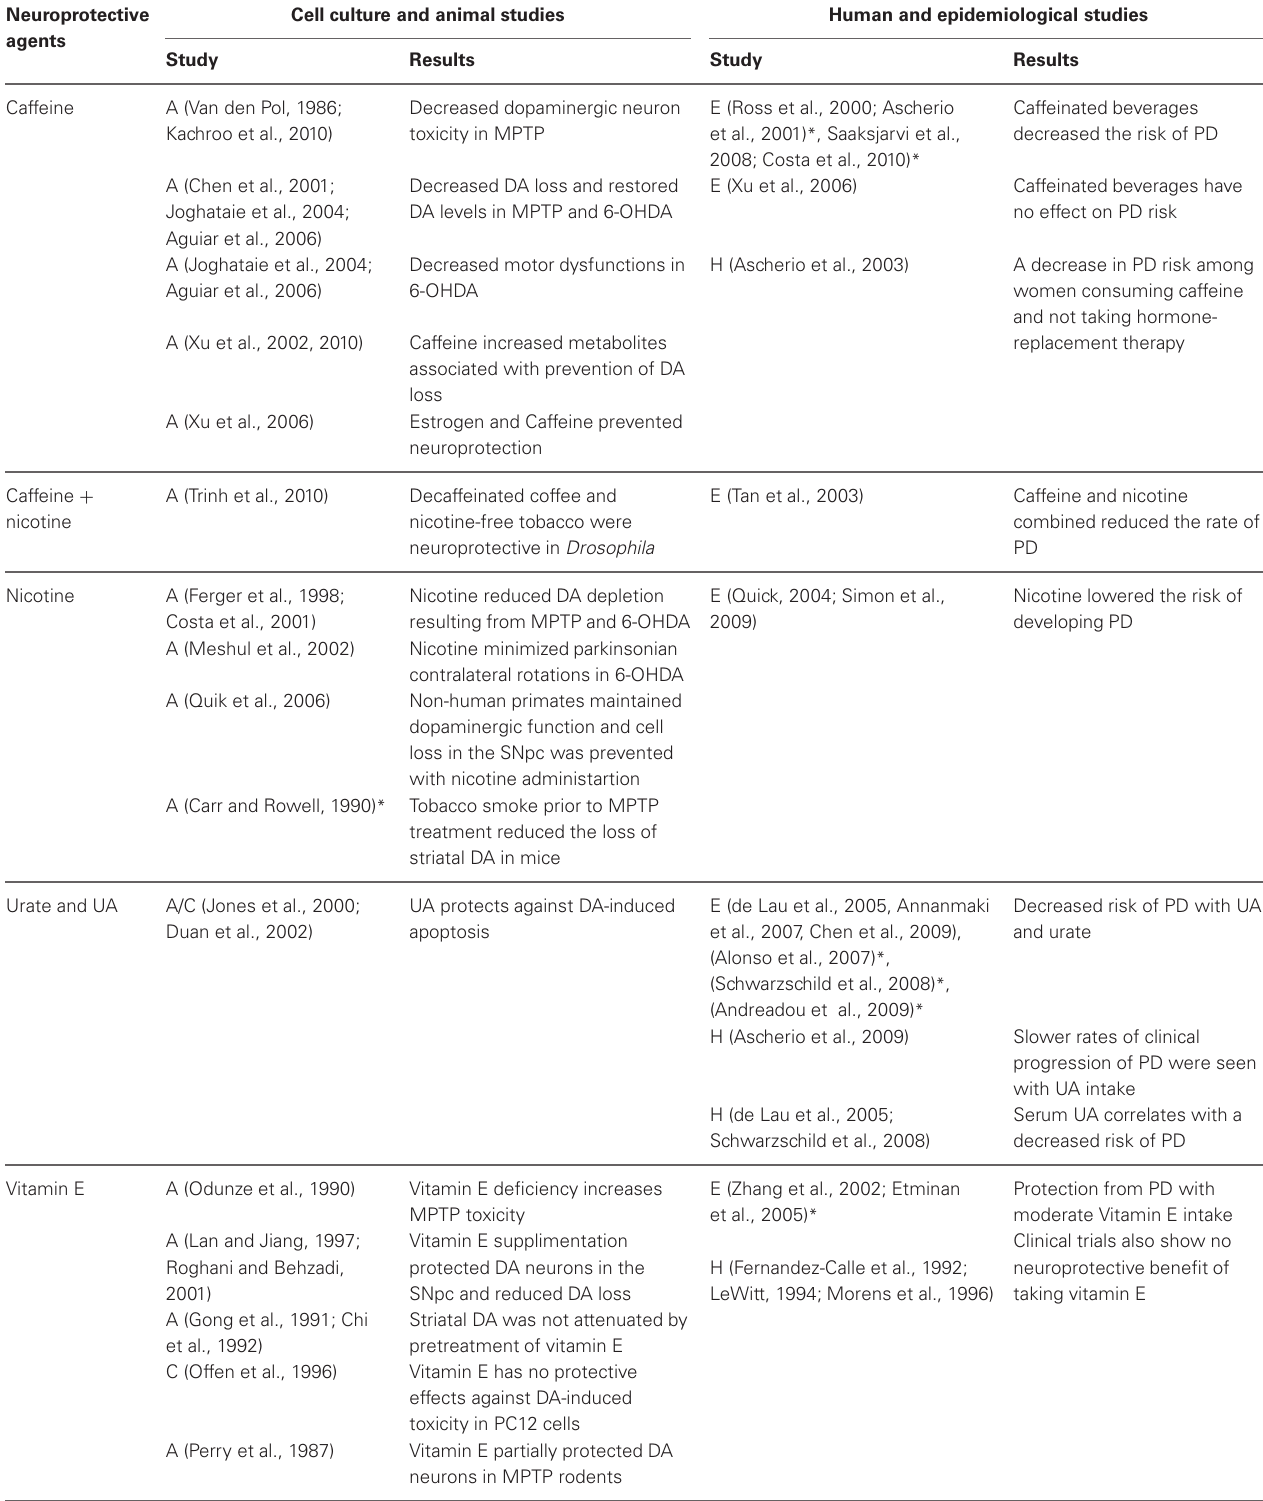
Table 1 | Neuroprotective Agents in PD models.